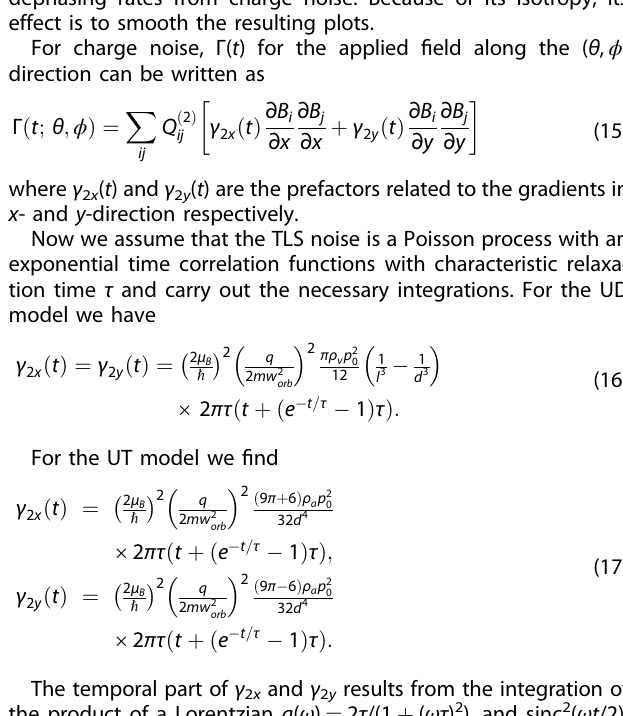
respectively. The anisotropy maps of T 2 for the various models are shown in Fig. 2. There is some redundancy in the maps since they are symmetric under the transformation θ → π − θ and ϕ → π + ϕ , stemming from T 2 ( B 0 ) = T 2 ( − B 0 ). This same redundancy also arises in the anisotropy maps of T 1 in Fig. 3. We have chosen to show the full angular ranges since in some instances the topology of the function is clearer this way. The number of maxima ( N max ), minima ( N min ), and saddle points ( N s ) in each map are shown in Table 1. When the dephasing and relaxation times in the maps are continuous functions without higher-order critical points, Morse theory can be applied. In particular for such functions on a 2D sphere (genus zero), they follow the relation: N max + N min = N s + 2. Table 1 shows how the topology of the function can change when parameters affecting the noise are varied. For the maps of Fig. 2e and f, Morse theory cannot be applied because the ridges in the maps correspond to a line of higher-order critical